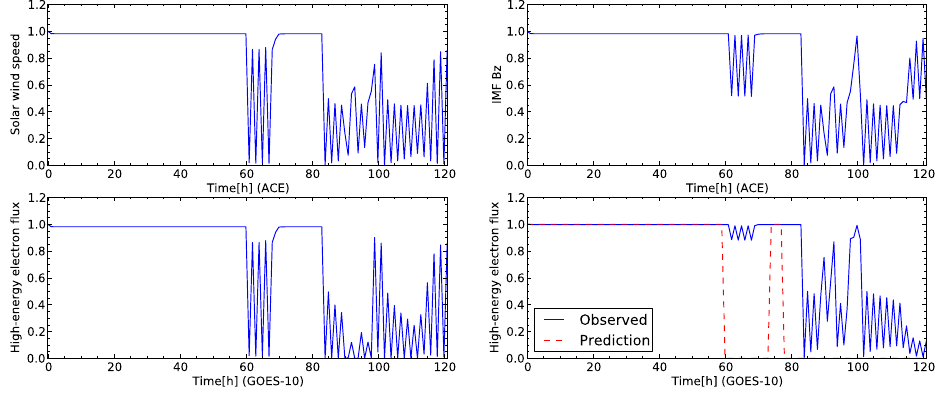
four-sensor model evaluates the test data. The value of a vertical axis represent a credibility corresponding to a sensor name indicated at the vertical axis. The name of the satellite for the sensor is represented at horizontal